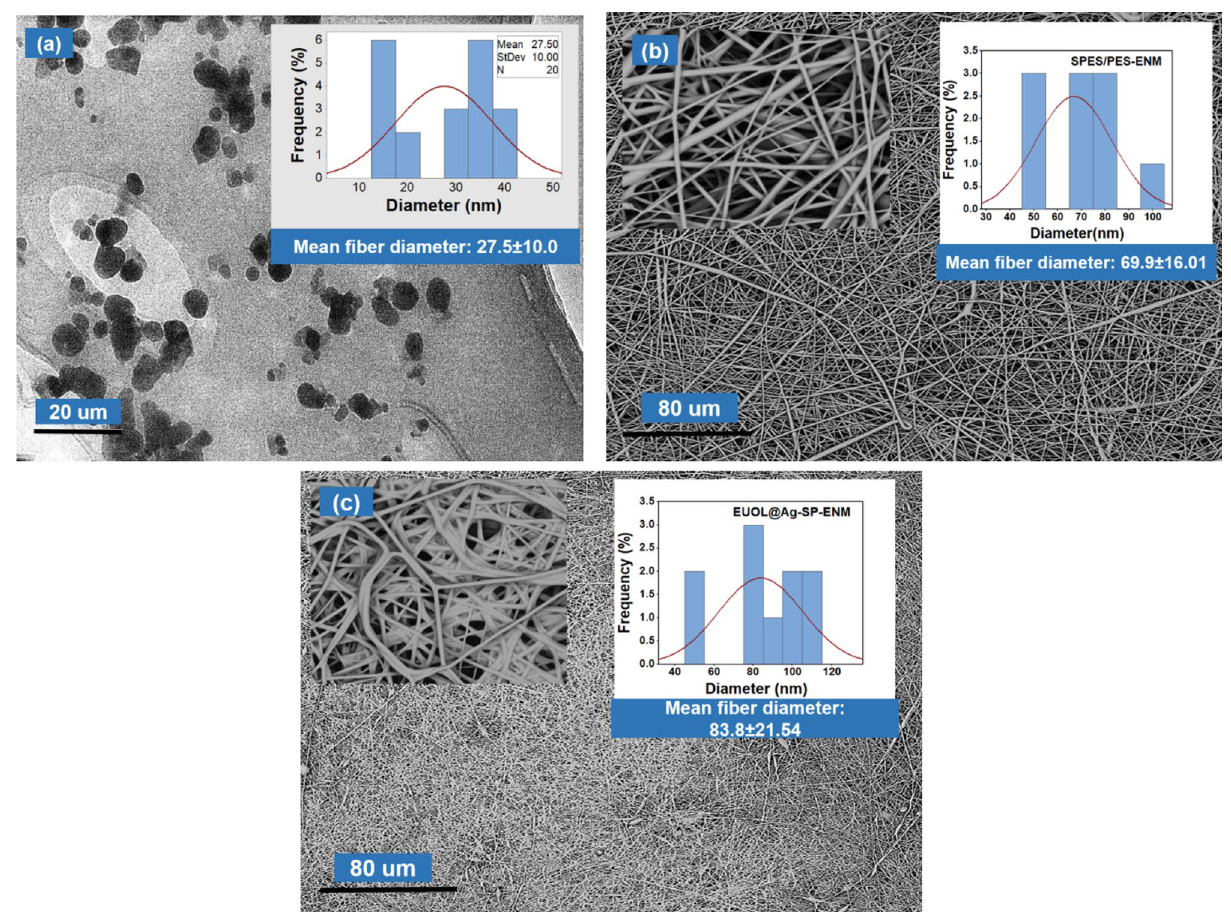
Figure 1. ( a ) TEM image of EUOL@AgNPs and SEM micrographs of ( b ) SP-1, and ( c ) SP -5